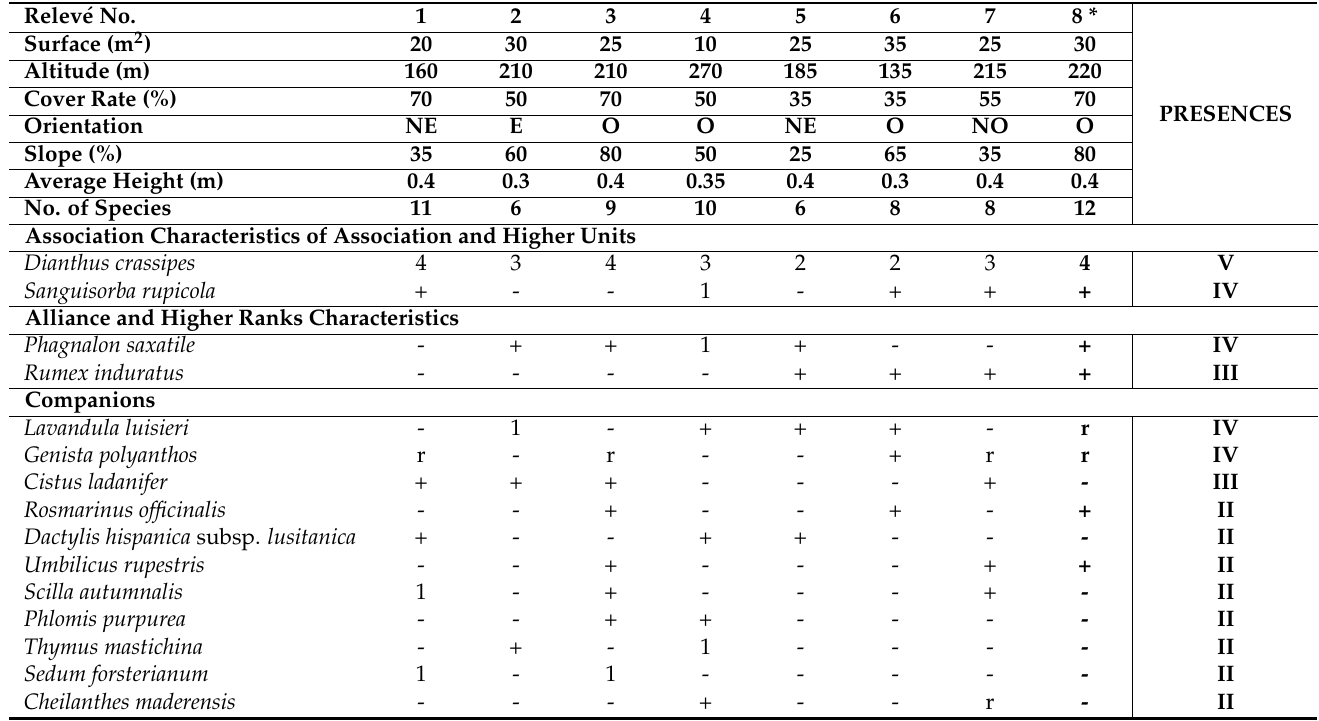
Table 2. Sanguisorbo rupicolae-Dianthetum crassipedis ass. nova hoc. loco (Rumici indurati-Dianthion lusitani, Phagnalo saxatilis-Rumicetalia indurati and Phagnalo saxatilis-Rumicetea indurati). Relev é No. 1 PRESENCESSurface